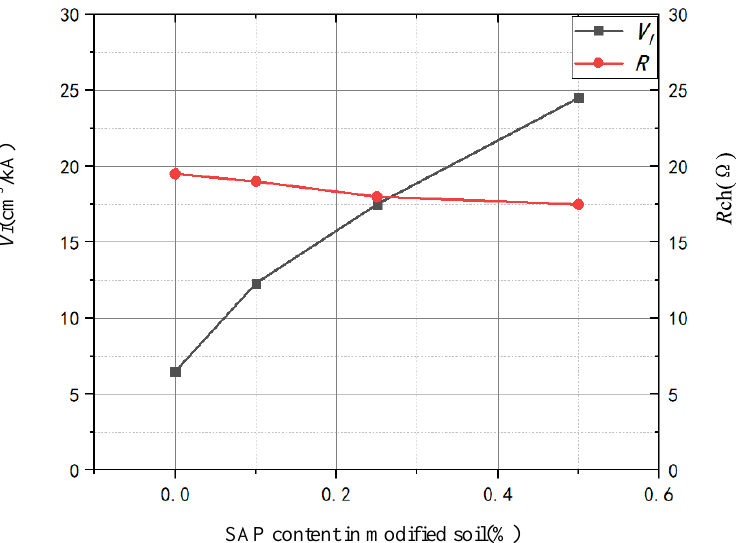
Figure 16. Curve of V I with the content of SAP.